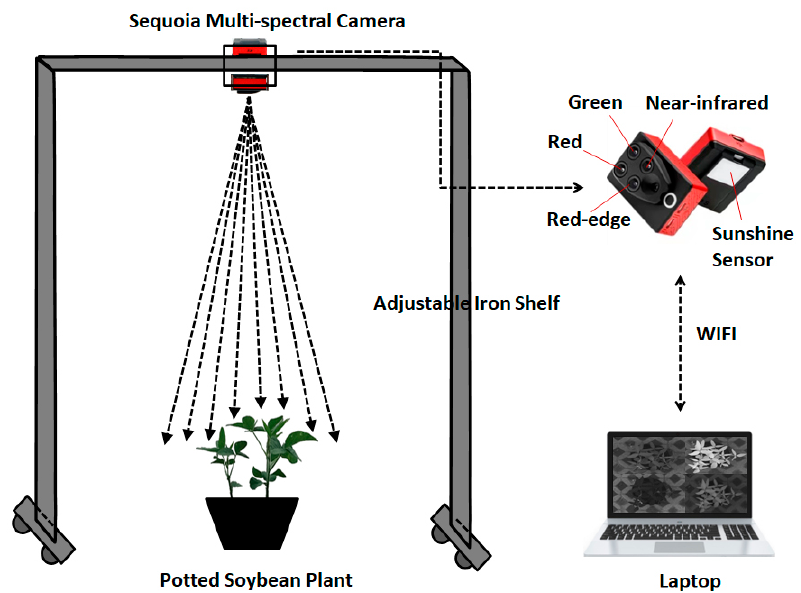
Figure 1. Schematic diagram of the acquisition system for a soybean plant.